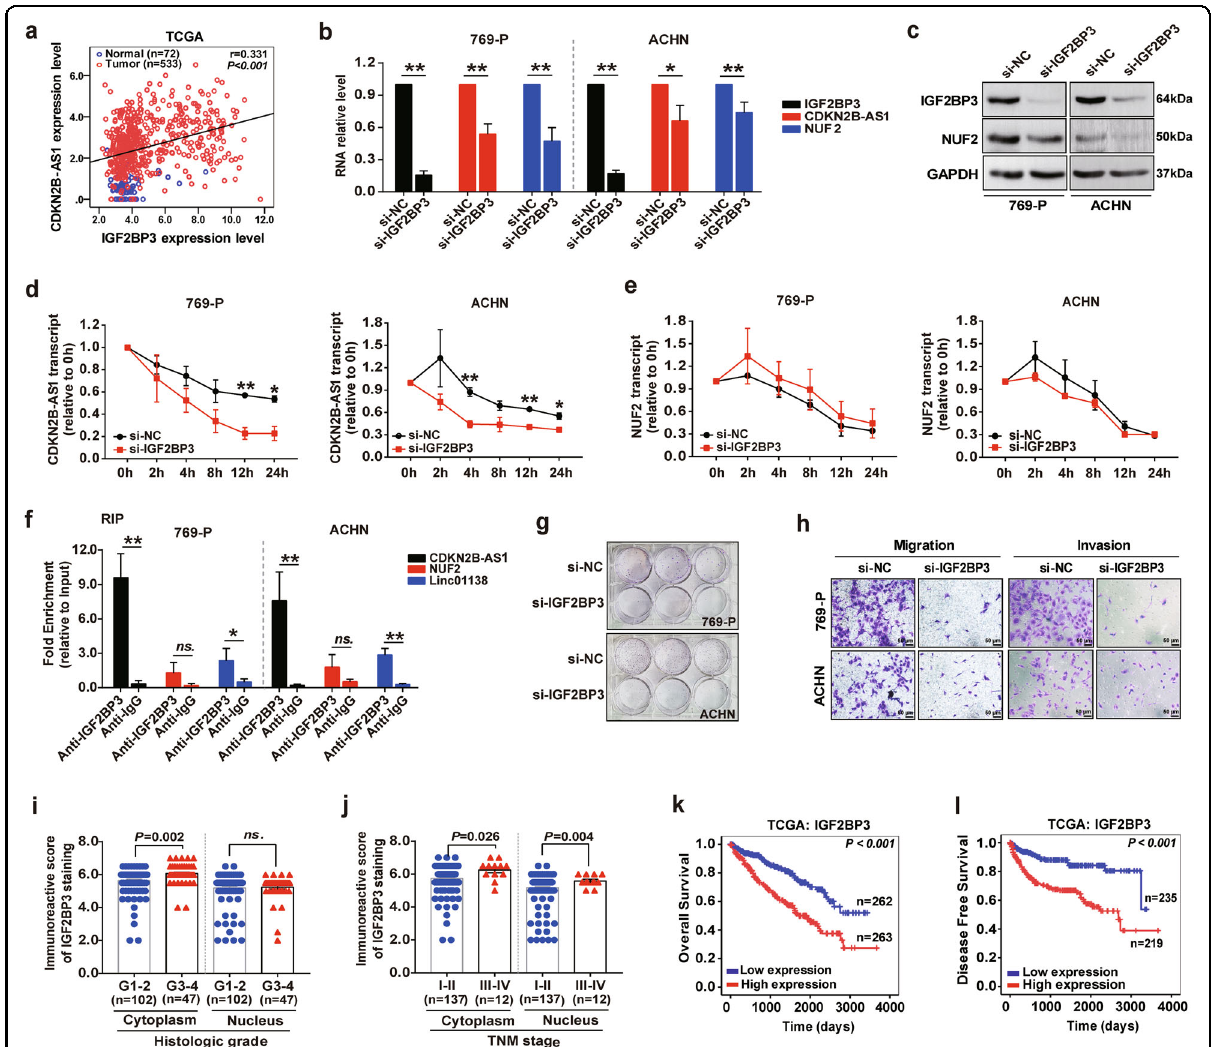
Fig. 5 CDKN2B-AS1 is stabilized by IGF2BP3 in KIRC. a Pearson correlation analysis of the relationship between CDKN2B-AS1 and IGF2BP3 levels in TCGA-KIRC dataset. Normal tissues are shown as blue circles ( n = 72) and tumor tissues as red circles ( n = 533). b – e 769-P and ACHN cells were treated with si-IGF2BP3 for 48 h; qRT-PCR analysis of IGF2BP3, CDKN2B-AS1, and NUF2 expression with β -actin as the internal control ( b ); western blot analysis of IGF2BP3 and NUF2 protein levels with GAPDH as the internal control ( c ); qRT-PCR analysis of CDKN2B-AS1 ( d ) and NUF2 mRNA ( e ) stability, RNA levels were measured after treatment with actinomycin D (5 μ g/mL) for 0, 2, 4, 8, 12, and 24 h, respectively, and compared to the level at 0 h. f RIP assay analysis of IGF2BP3 enrichment in CDKN2B-AS1, NUF2, and Linc01138 in 769-P and ACHN cells; RIP enrichment was measured using qRT-PCR normalized by the input RNA. g Colony formation assays were performed to assess cell proliferation in 769-P and ACHN cells treated with si-IGF2BP3. h Transwell assays were used to evaluate migration and invasion in 769-P and ACHN cells transfected with si-IGF2BP3. Scale bar: 50 μ m. i , j Immunostaining score of IGF2BP3 in immunohistochemistry of patients with a different histologic grade ( i ) and TNM stage ( j ) from the paraf fi n- embedded KIRC tissue microarray (No. HkidE180Su02). k , l Kaplan – Meier analysis showed the overall survival and disease-free survival in KIRC patients based on the expression of IGF2BP3 in TCGA dataset; the high and low expression groups were divided by the median of IGF2BP3 levels. Error bars represent the SEM from at least three independent experiments, ** p < 0.01 vs. si-NC or anti-IgG, * p < 0.05 vs. si-NC or anti-IgG. ns. no signi fi cance ( p > 0.05). P value calculated by independent sample t test ( b – j ), or log-rank test ( k , l